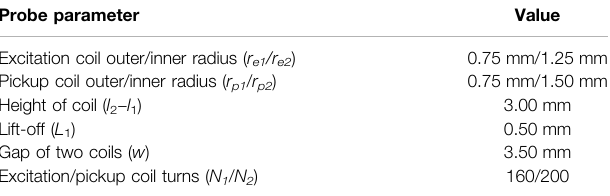
TABLE 1 | Probe parameters.